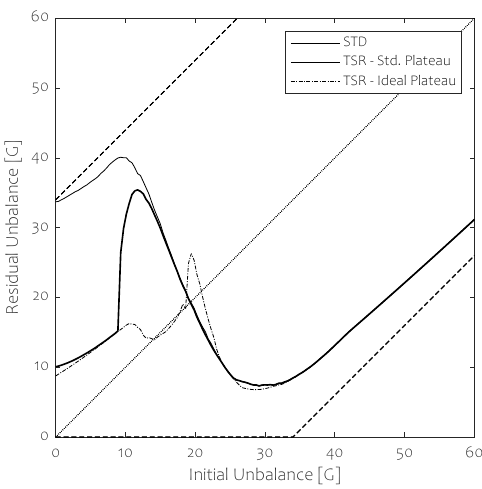
Figure 16. The balancing outcomes for µ r = 1, c r = 0.5 whereby the lower speed plateau was altered from 1.06 (standard) to 1.03 (ideal). The STD balancing outcome is presented as well for illustration